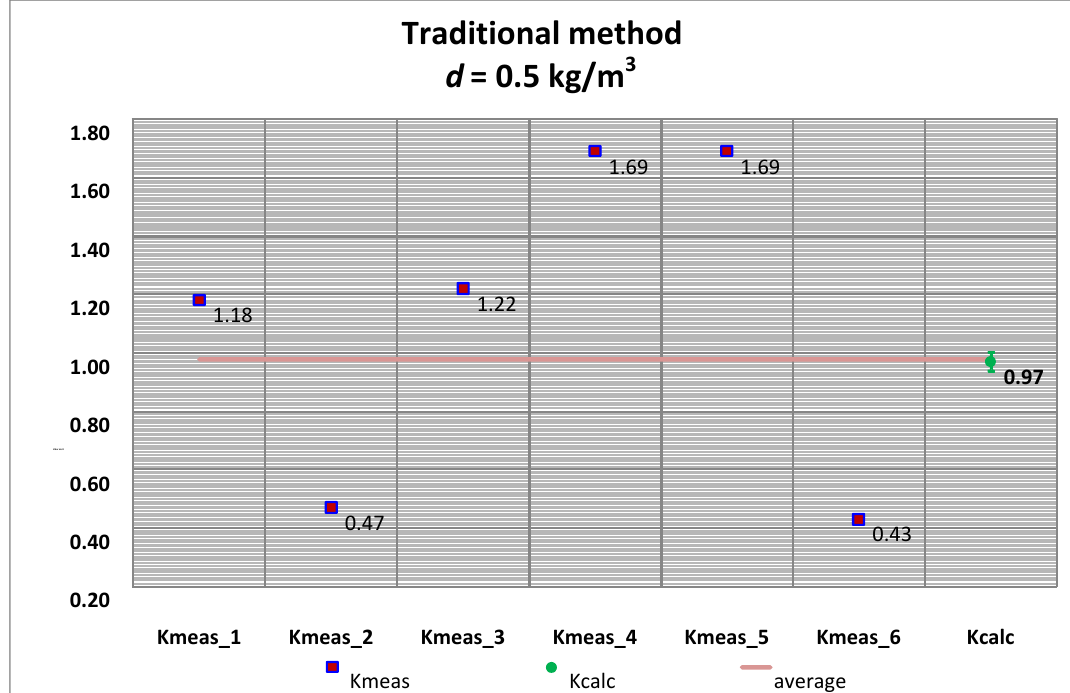
values. Medium accuracy hydrometer. Traditional Figure 22. K meas